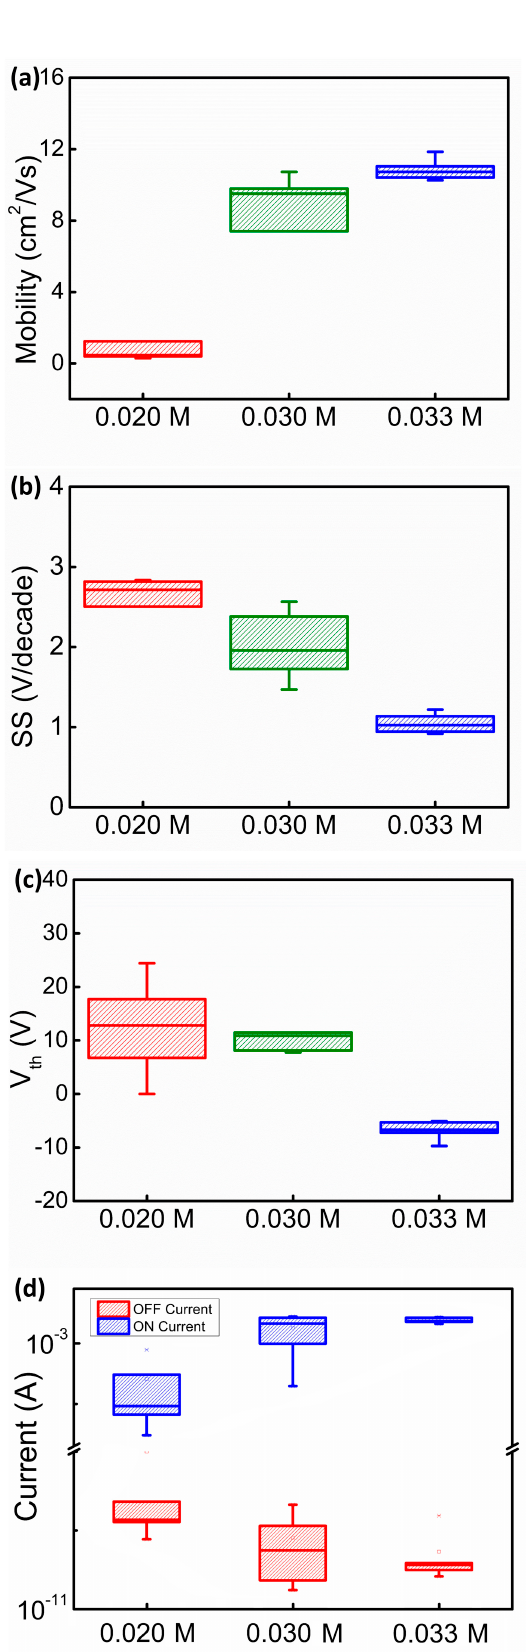
Figure 5. Extracted thin-film transistor performance parameters: ( a ) field-effect mobility in saturation regime, ( b ) subthreshold swing ( SS ), ( c ) V th , and ( d ) I on and I off .